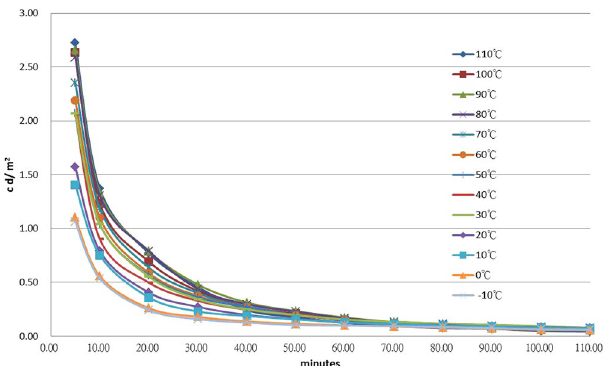
Figure 2. The TL-time plot of Fig. 1. The right hand side shows symbols for various temperatures, the bottom scale indicates the duration of the afterglow